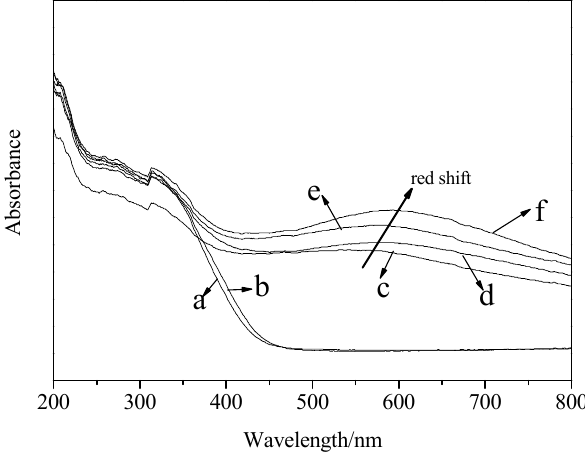
Figure 4. The diffuse reflectance UV–vis spectra of Bi 2 WO 6 ( a ); Bi 2 WO 6 -400 ( b ) and Au/Bi 2 WO 6 -400 calcined at different temperatures: 80 °C ( c ); 200 °C ( d ); 300 °C ( e ); 400 °C ( f ).